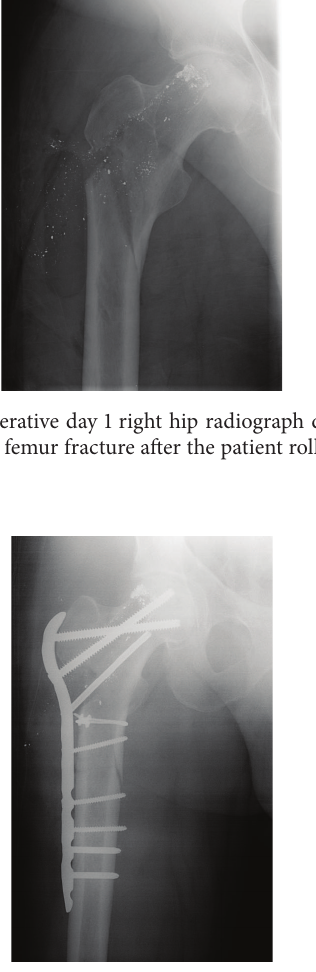
Figure 4: Right hip radiograph after open reduction and internal